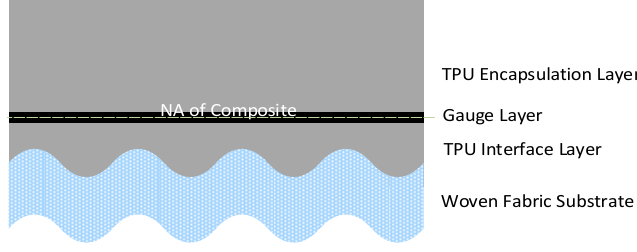
Figure 1. Printed fabric assembly showing the ideal position of the strain gauge.